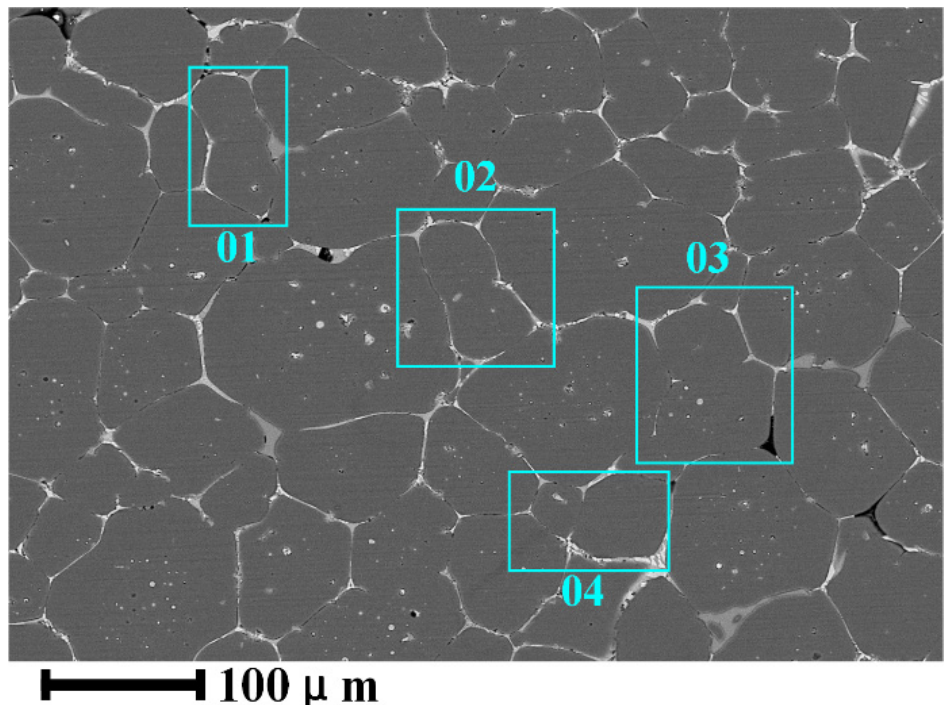
Figure 8. “8”-shaped grains.